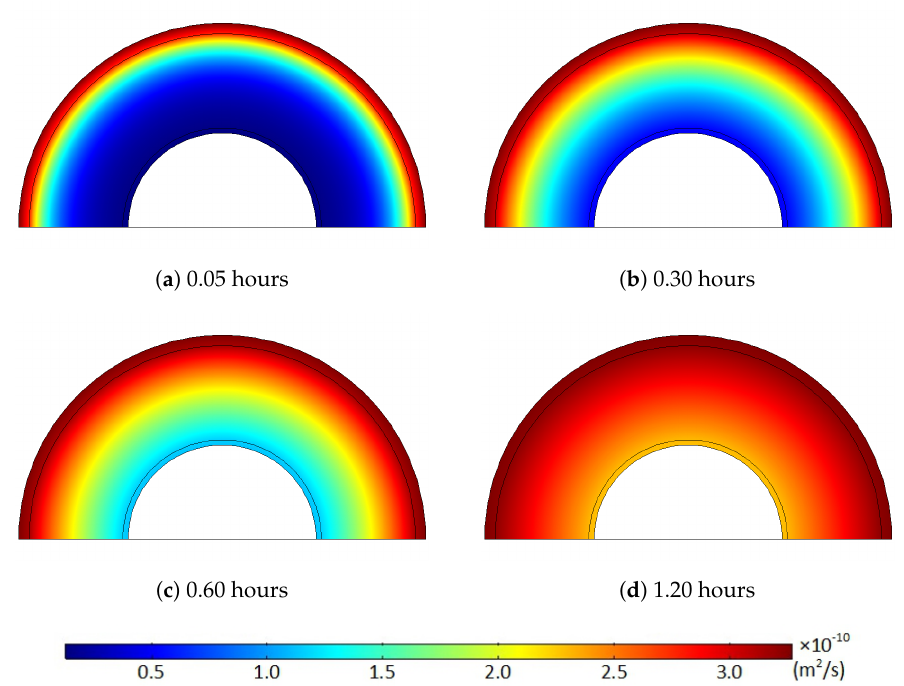
Figure 6. Diffusion coefficient (m 2 /s) of the XLPE and semiconductors, which corresponds to the temperature change where the target degassing chamber temperature is 343.15 K: ( a ) 0.05 hours, ( b ) 0.30 hours, ( c ) 0.60 hours, ( d ) 1.20